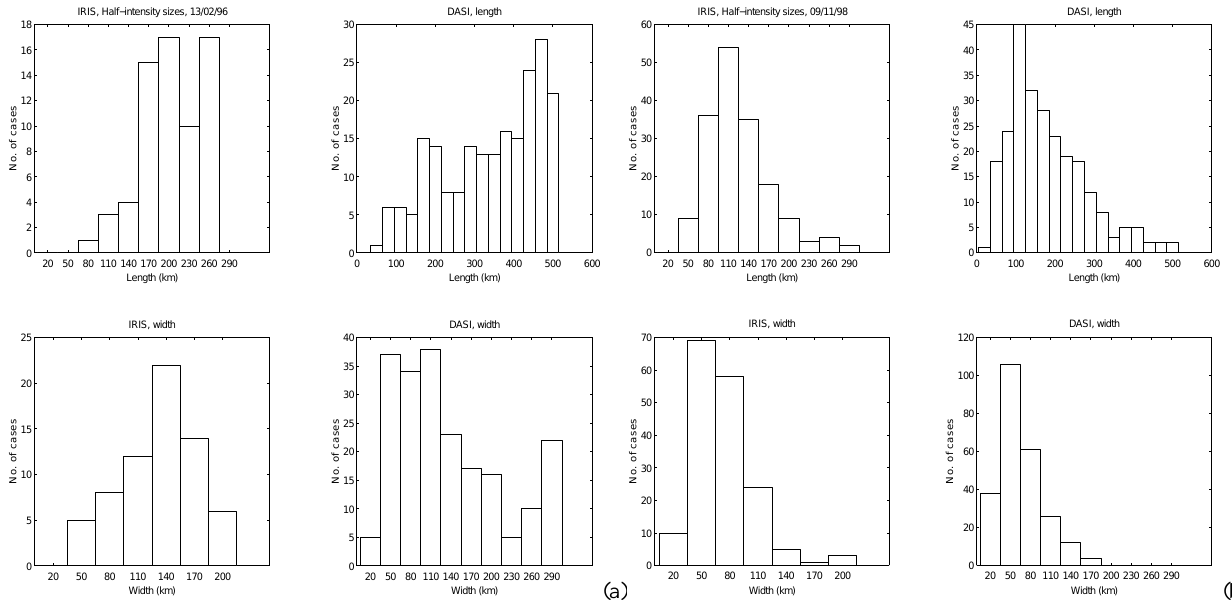
Fig. 8. Histograms of the lengths and widths of the half-intensity contours for the same periods (a) and (b) as in Fig. 7. Half-intensity contours are defined by ratios, r , 0 . 4 < r < 0 . 6. IRIS results are shown on the left side and DASI results on the right side of each figure.